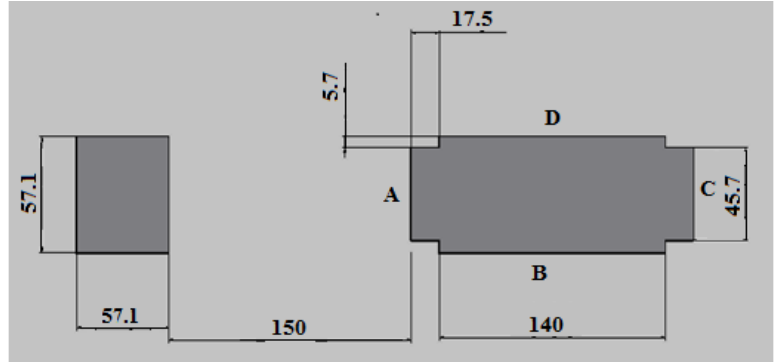
Fig. 1. Plan of Corner-cut and interfering building (all dimensions in meter).